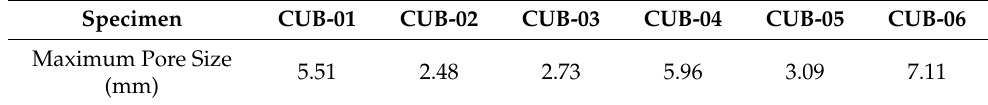
Table 3. Maximum Pore Size.